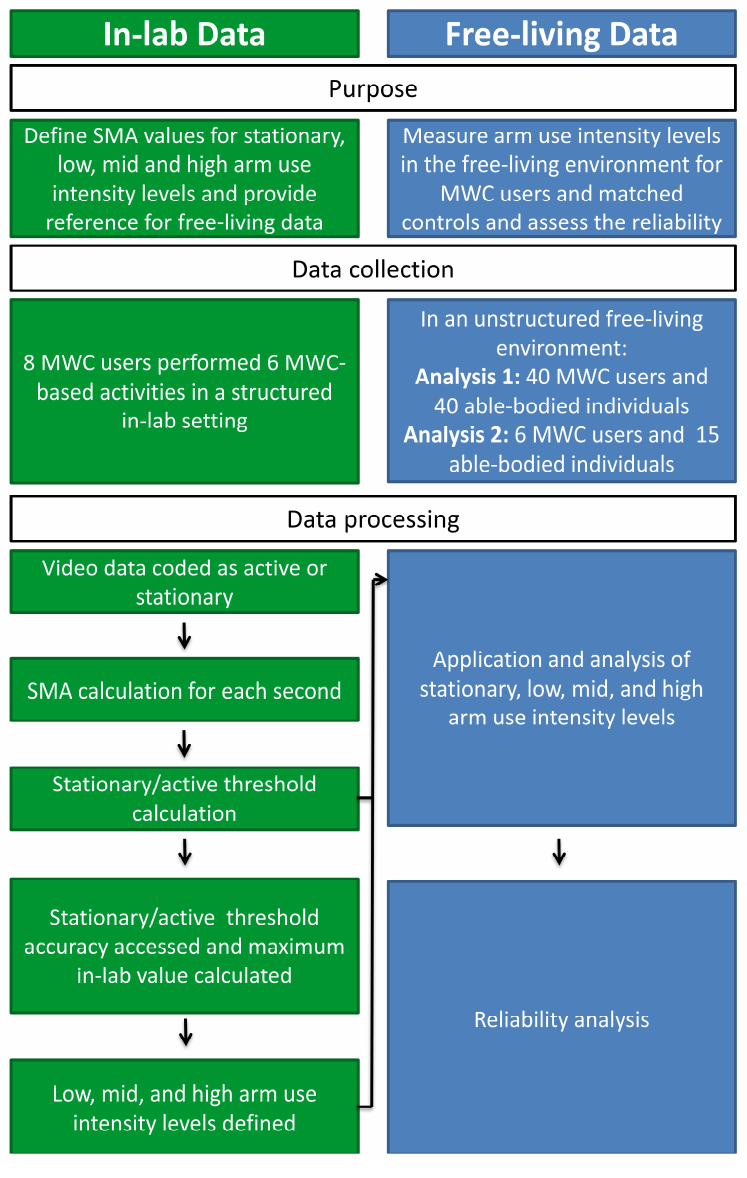
Figure 1. The purpose, data collection, and data processing flow of defining signal magnitude area (SMA) arm use intensity levels for the in-lab and free-living data utilized in this